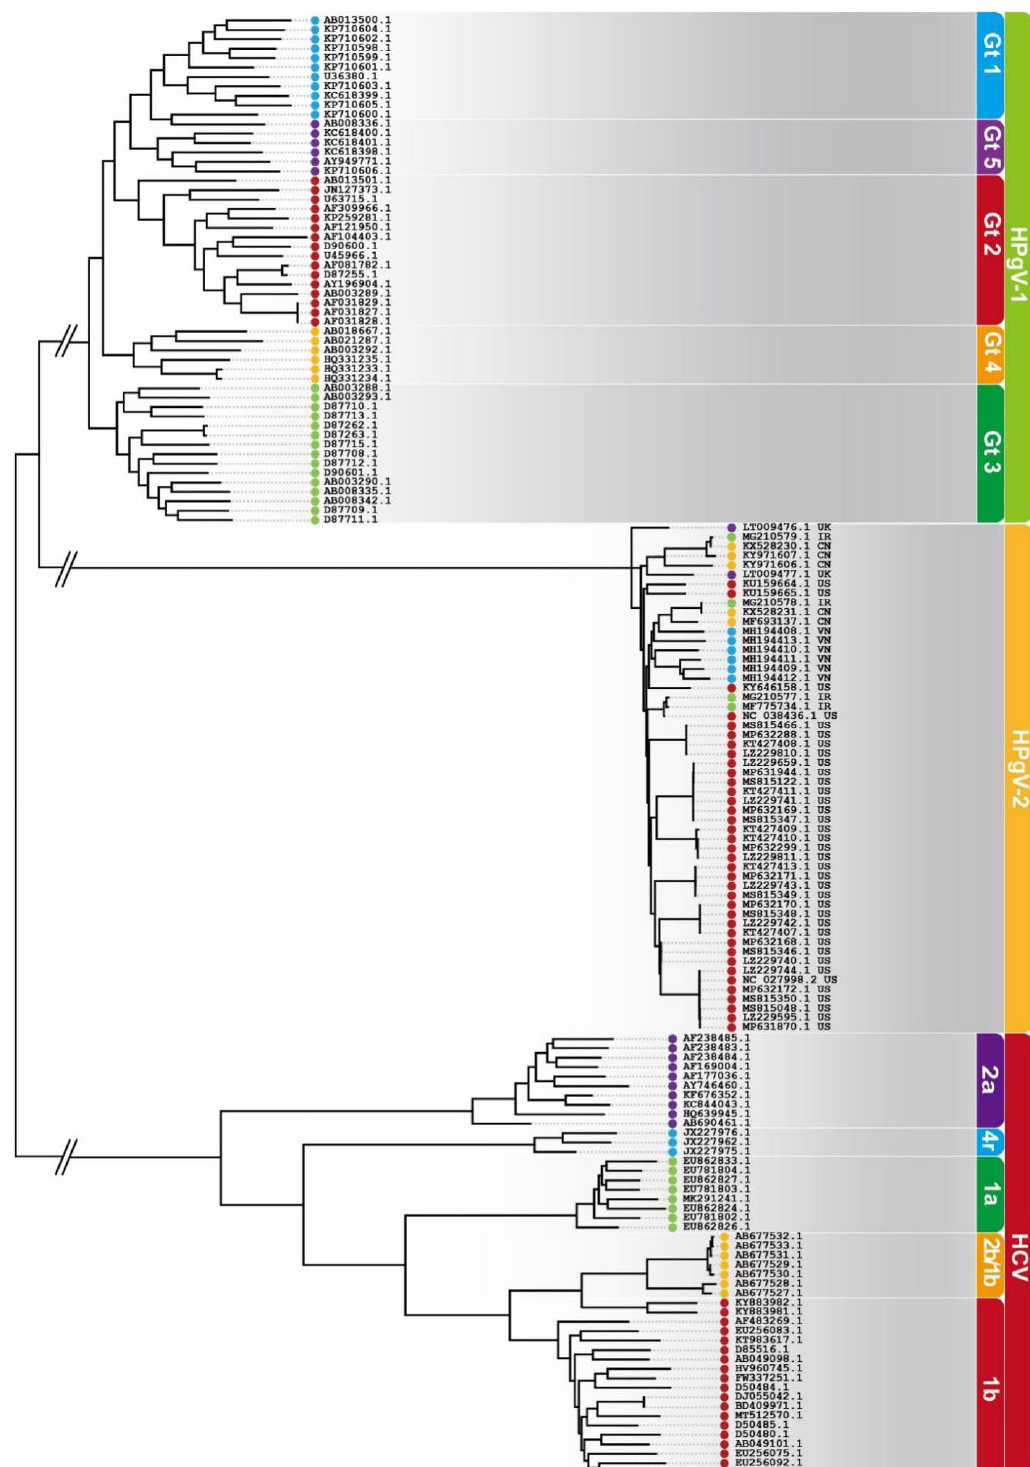
Figure 3. Phylogenetic trees of HPgV-1, HPgV-2 and HCV nucleotide sequences generated with the maximum likelihood method. The origins of HPgV-2 isolates are indicated as UK ( ● ) for United Kingdom, IR ( ● ) for Iran, CN ( ● ) for China, US ( ● ) for the United States and VN ( ● ) for Vietnam.